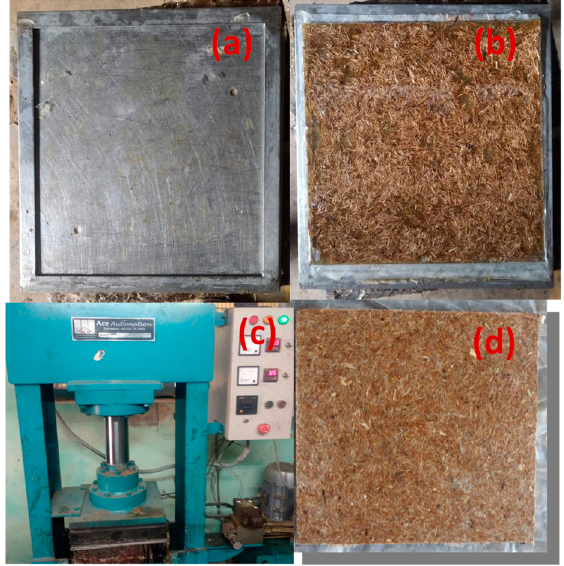
Figure 4. Composite fabrication process: ( a ) Fabrication mould; ( b ) Laying process; ( c ) Pressing process;( d ) Fabricated composite specimen.